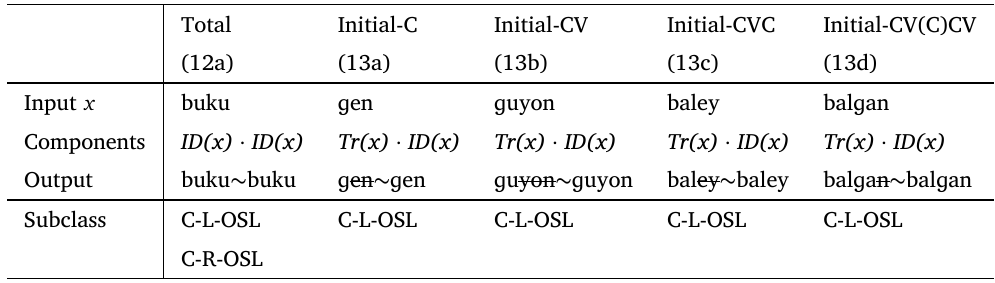
Table 3: C-OSL treatment for total and initial partial reduplication Total Initial-C